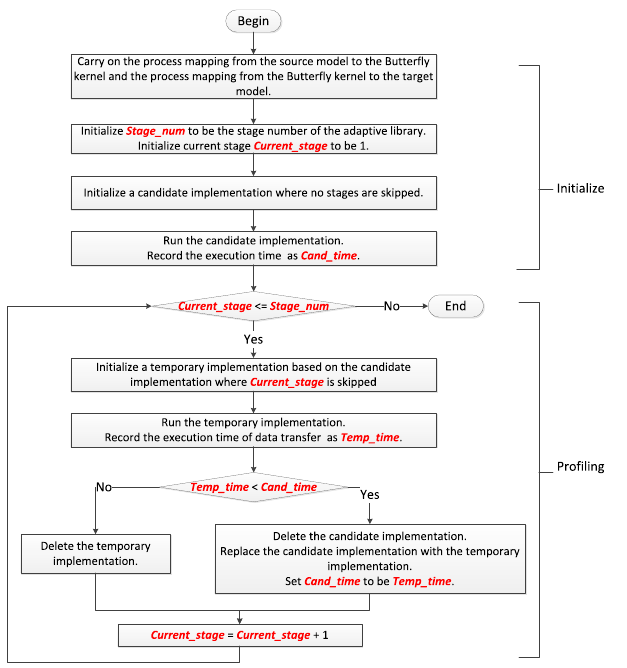
Figure 13. A flow chart for determining an appropriate implemen- tation of the adaptive data transfer library.